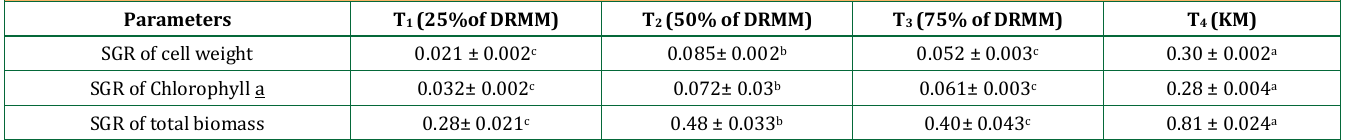
Table 3: Specific Growth Rates (Sgrs) on The Basis of Cell Weight, Chlorophyll a and Total Biomass of S. Platensis Grown in Supernatant of Different DRMM, and